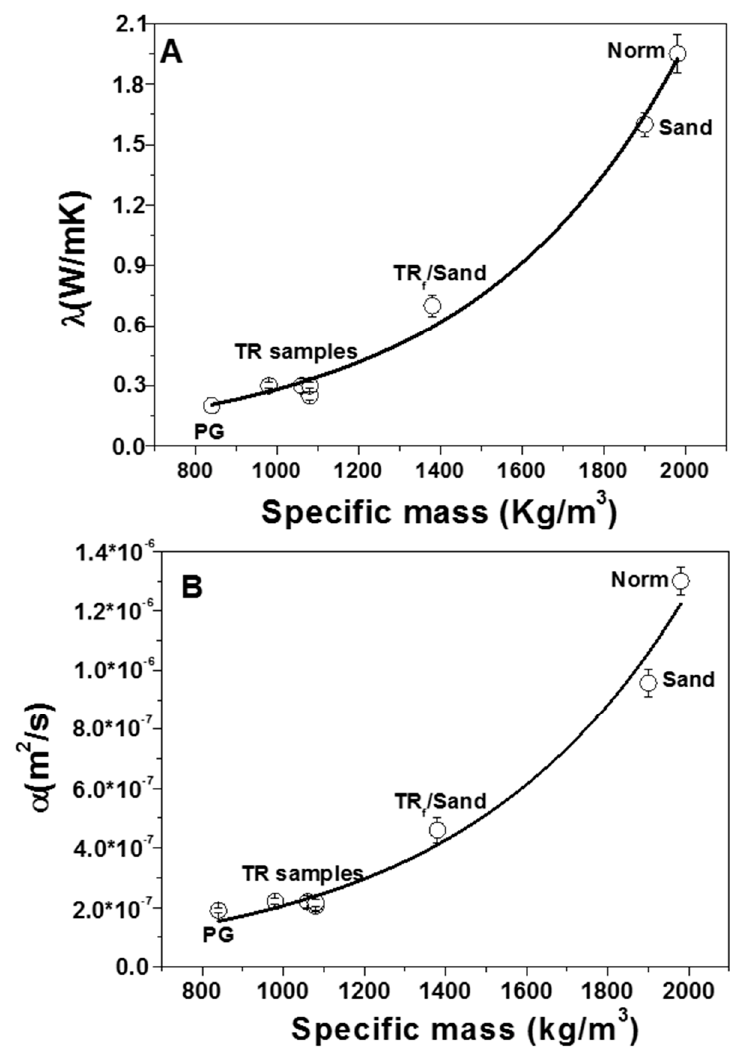
Figure 9. ( A ) Thermal conductivity and ( B ) thermal diffusivity of the cement mortar specimens.